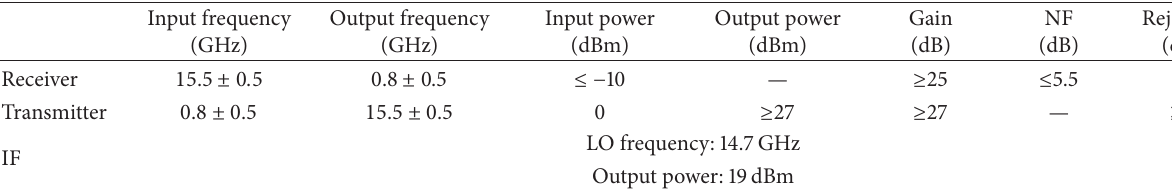
Table 1: Specifications of Ku-band transceiver front-end [3].